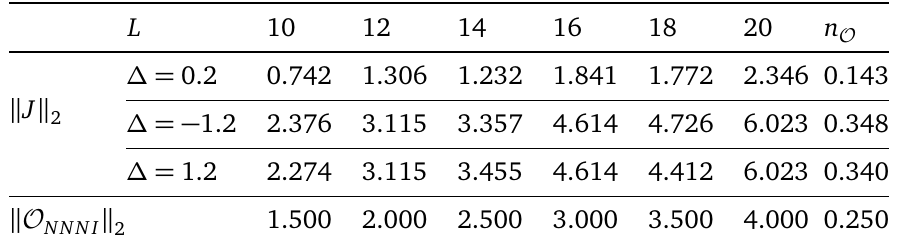
Table 1: The norms of the perturbing operators J and O